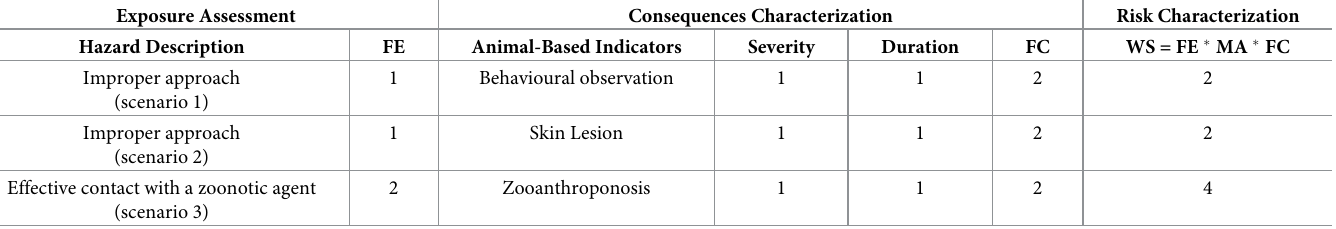
Table 2. Welfare score values (FE = frequency of exposure; FC = frequency of consequences; MA = magnitude of consequences; WS = Welfare Score). Adapted from